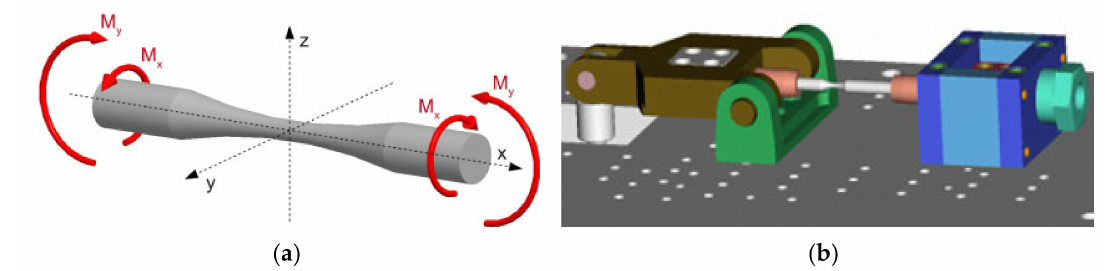
Figure 12. Loading the specimen by a combined stress: ( a ) bending—torsion; ( b ) the 3D model of the designed loading mechanism.